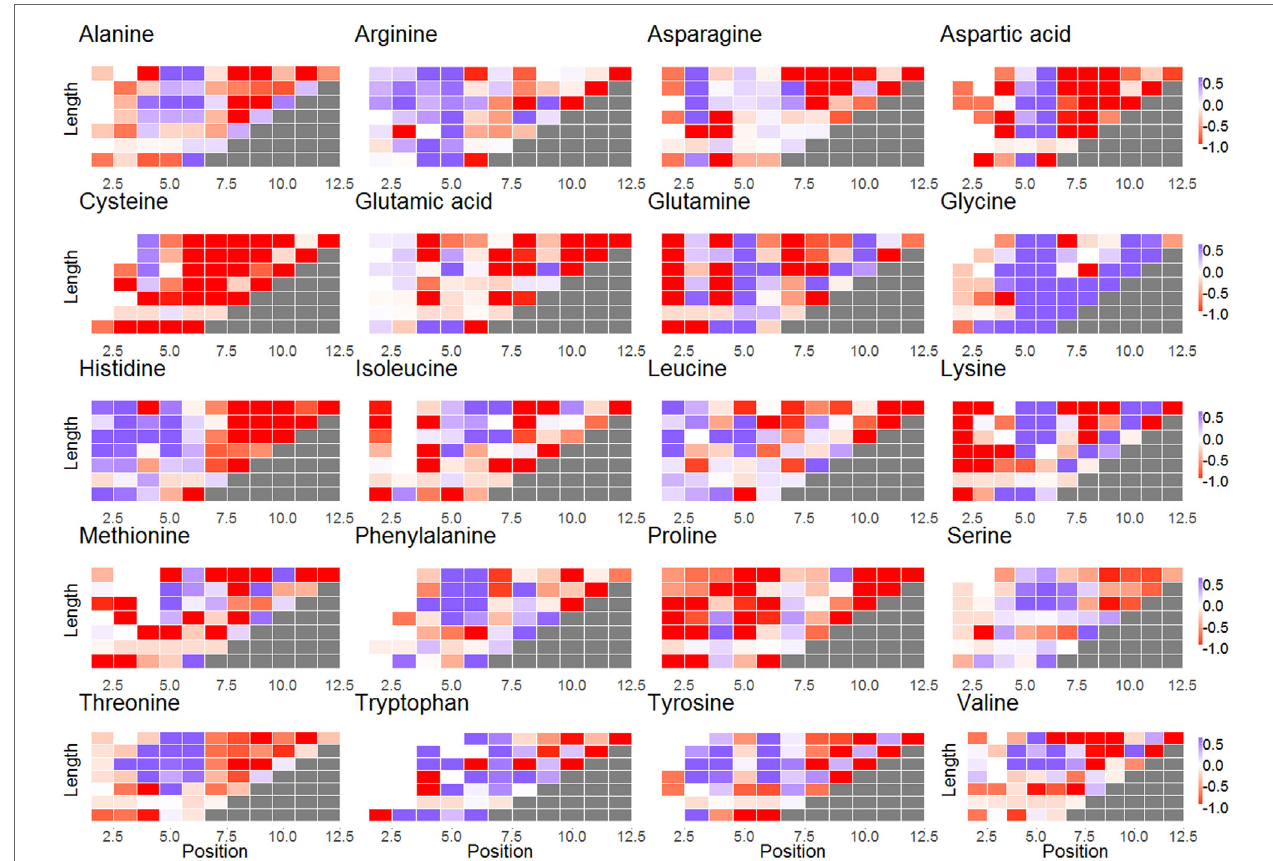
FigUre 3 | Subplots of selection factors of different lengths for each amino acid. The x -axis represents the different locations in CDR3; the y -axis represents the different lengths of the CDR3. The blue cells represent log( q ) values larger than 0 for codon in a certain position. The red cells represent log( q ) values lower than 0. The white cells indicate that there was no